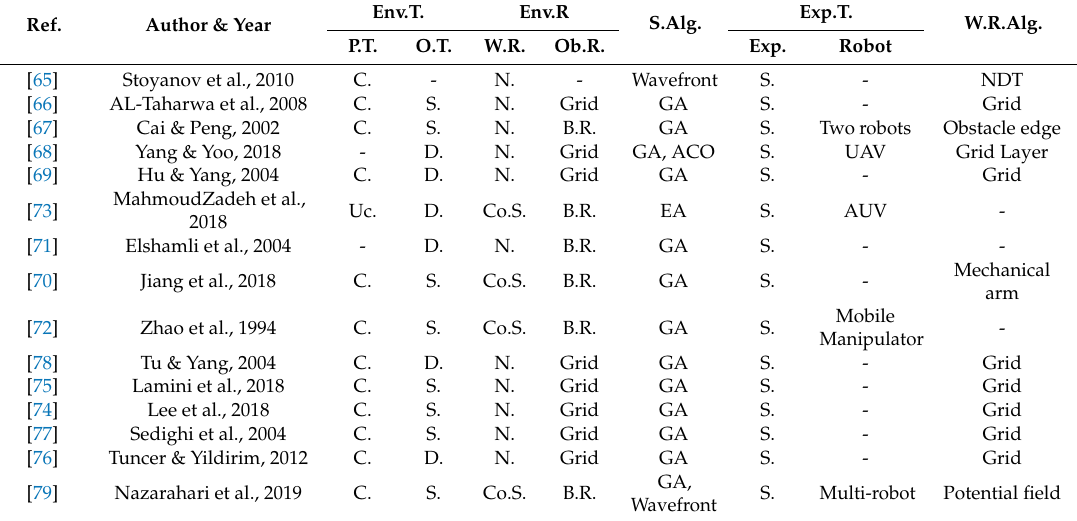
Table 4. Classification of the paper using the heuristic-based algorithm (Wavefront and Genetic algorithm (GA)). Ref.